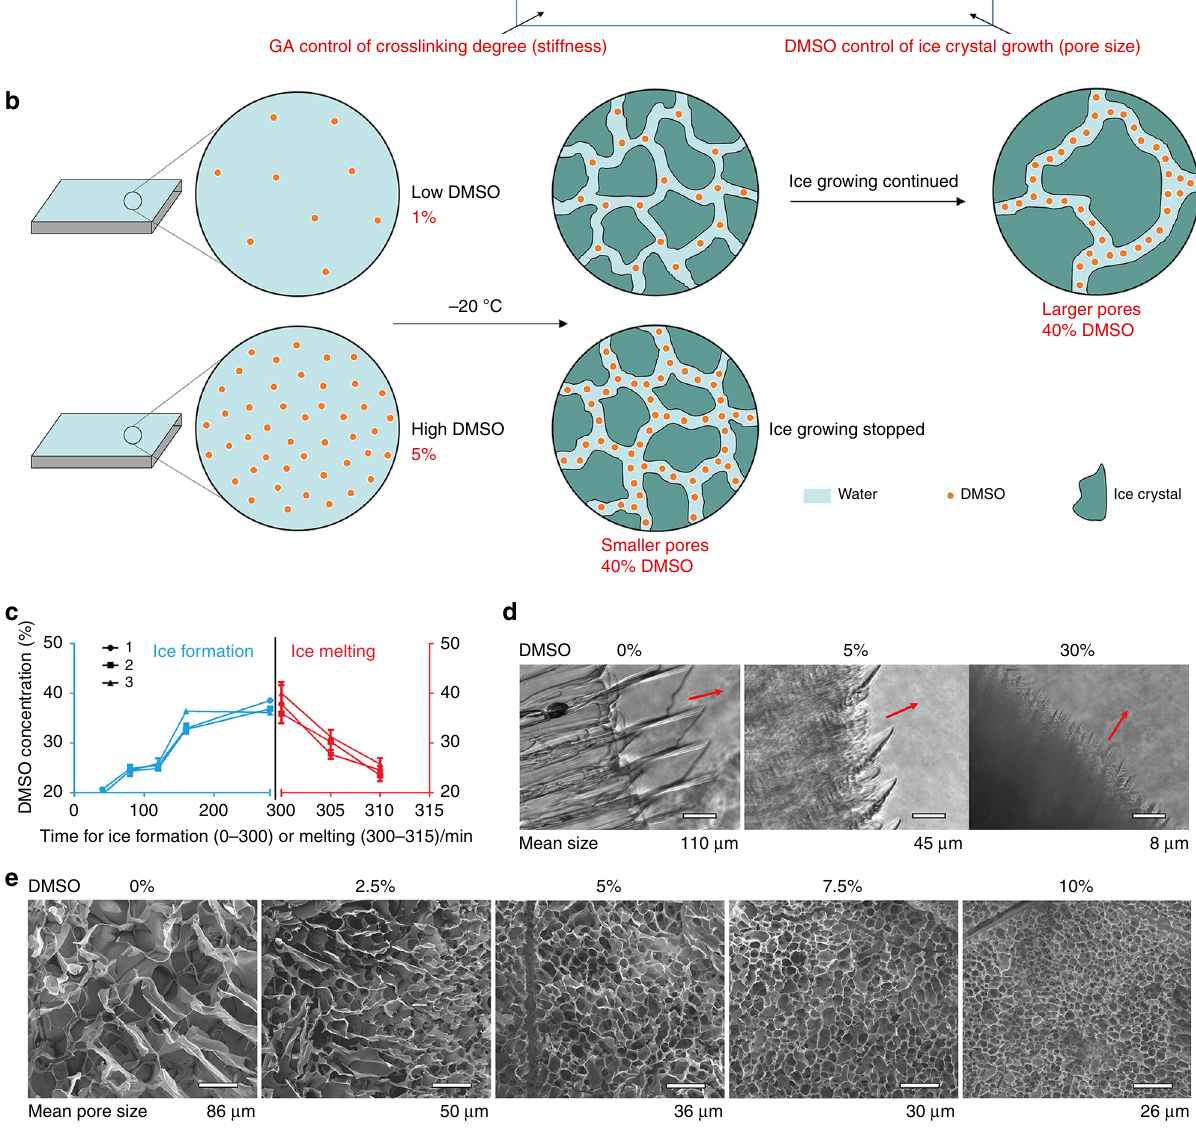
Fig. 1 Precise control of scaffold pores sizes by cryoprotectant-regulated ice crystal growth. a Schematic of scaffold fabrication via cryogelation of pre- polymer solution (e.g., gelatin, HA, or PEG) in the presence of cryoprotectant (e.g., DMSO) for pore size control and chemical cross-linker (e.g., GA) for stiffness control. b Mechanism for DMSO-enabled pore size control via regulation of ice crystal growth. A higher initial concentration (e.g. 5% vs. 1%) of DMSO in the gelatin – GA precursor solution caused faster DMSO accumulation in the non-frozen liquid phase to a concentration of ~ 40%, at which point further ice crystal growth was inhibited, resulting in smaller ice crystals and corresponding pore sizes. c Characterization of DMSO accumulation during ice crystal growth in gelatin – GA precursor solution. Data are means ± s.e.m. ( n ≥ 2). d Ice crystal growth depends on the DMSO concentration in directional freezing (arrows indicate the direction of ice growth). Scale bar: 100 μ m. e SEM images of gelatin scaffolds cross-linked by GA demonstrating the correlation of pore size and DMSO concentration. Scale bar: 100 μ